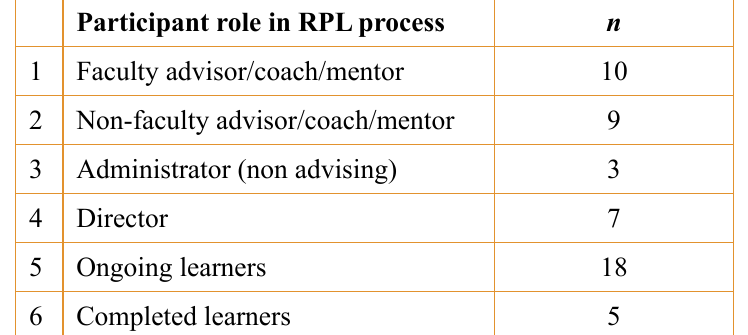
Breakdown of Study